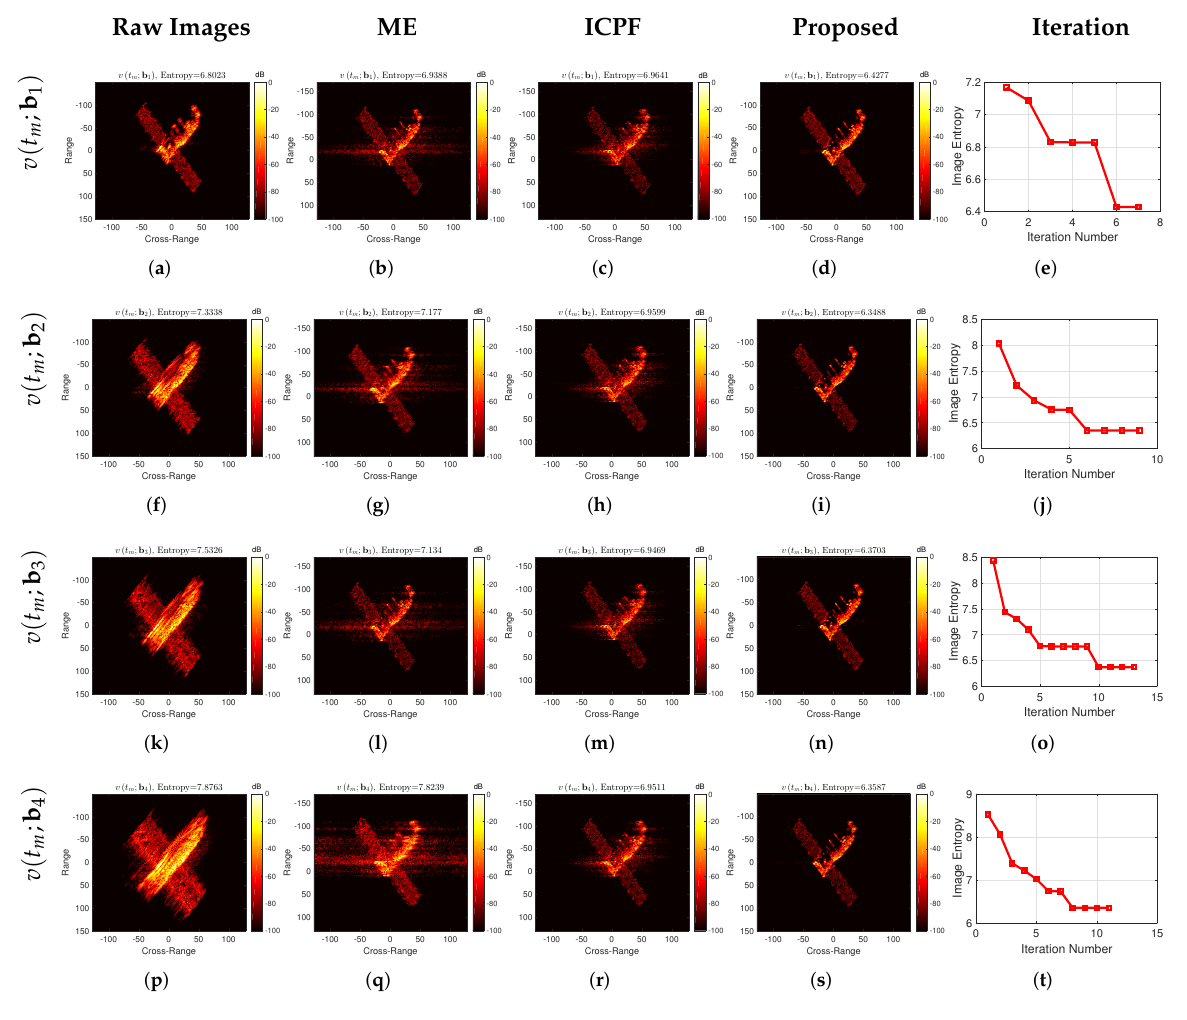
Figure 9. Experimental results of TG-I electromagnetic simulation under different motion conditions. The leftmost column shows the imaging results without high-speed motion compensation; the second column shows the high-speed compensation imaging results by ME; the third column shows the high- speed compensation imaging results by ICPF; the fourth column shows the high-speed compensation imaging results of the proposed algorithm; the rightmost column is the image entropy against the iteration number of the proposed algorithm.